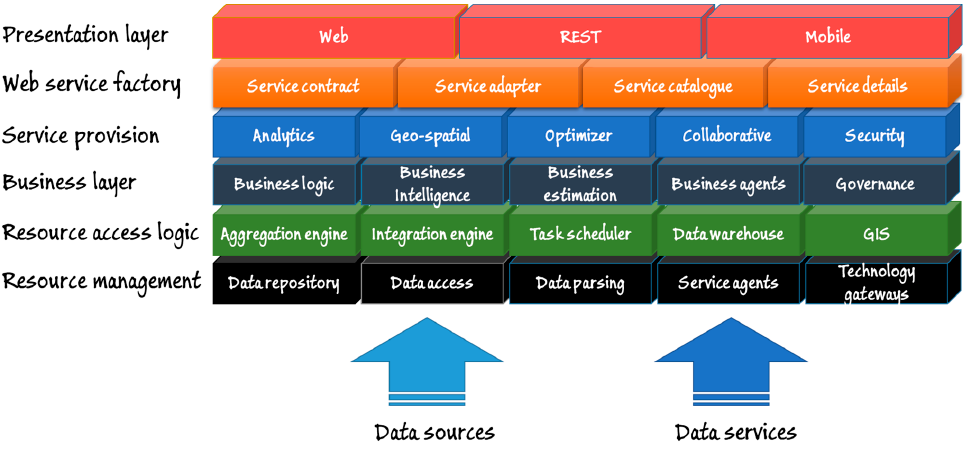
Figure 8. Architecture of the system.